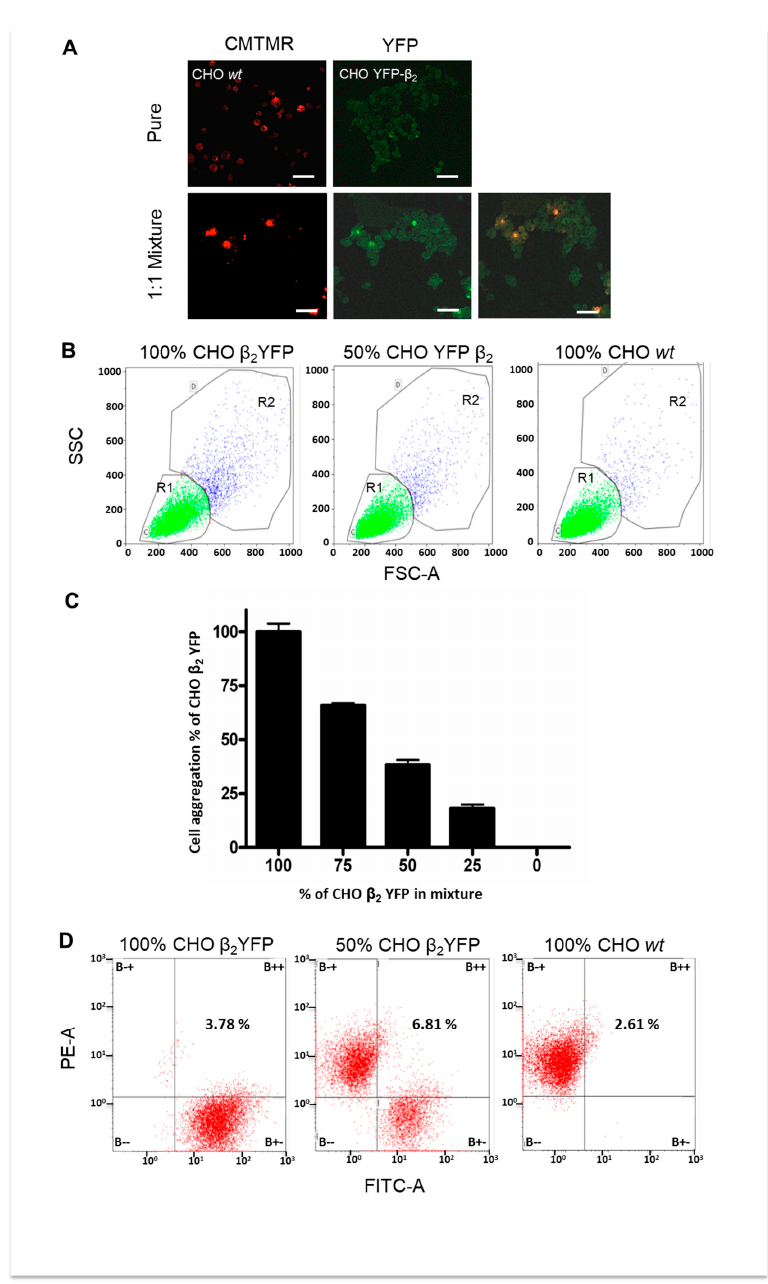
Figure 5. Mixing CHO β 2 YFP with CHO wt cells decreases the extent of cell aggregation. ( A ) CHO wt and CHO β 2 YFP cells were cultured for cell-aggregation assay as in Figure 3. CHO wt were pre-stained with CMTMR. In addition to the pure cell lines, three mixtures of CHO β 2 YFP cells and CHO wt have been assayed. A 30 µ L sample of each tube was dropped on slides and imaged by a confocal microscope. The upper panel is for aggregates of pure CHO wt cells imaged in red and pure CHO β 2 YFP cells imaged in green. The lower panel shows aggregates formed by a 1:1 mixture of CHO wt and CHO β 2 YFP cells imaged in red and green. (Bar scale is 30 µ m). ( B ) Representative dot-plots from flow cytometry assay are shown. The events in R2 are the aggregated population. ( C ) The aggregates of R2 were also analyzed by fluorescence-activated cell sorting. Representative dot-plots of red vs. green fluorescence are shown. Numbers are the proportion of mixed aggregates in percent. ( D ) The extent of cell aggregation of the three different mixtures (3:1, 1:1, and 1:3 ratios) was illustrated as the percent of the aggregation of pure CHO YFP- β 2 cells. Values are mean ± SED from four independent